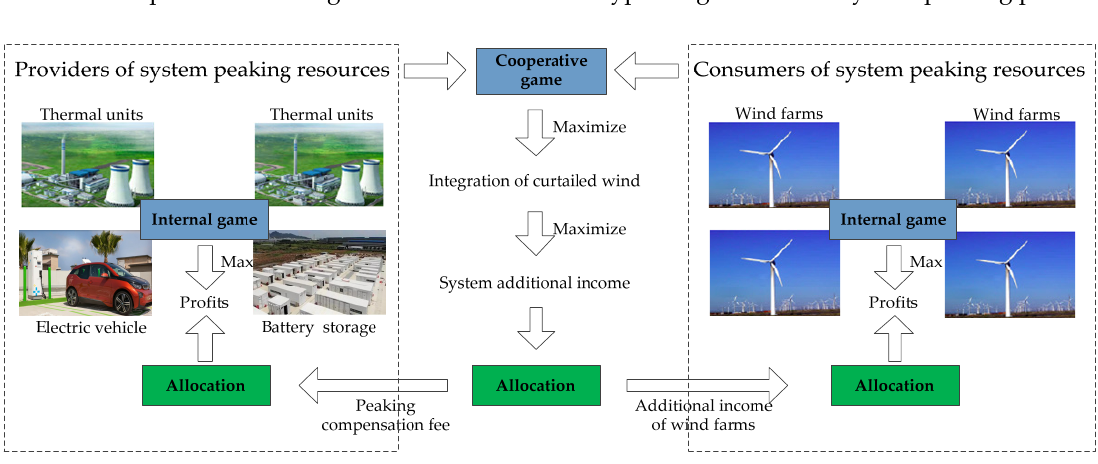
Figure 1. The games of system peaking process.